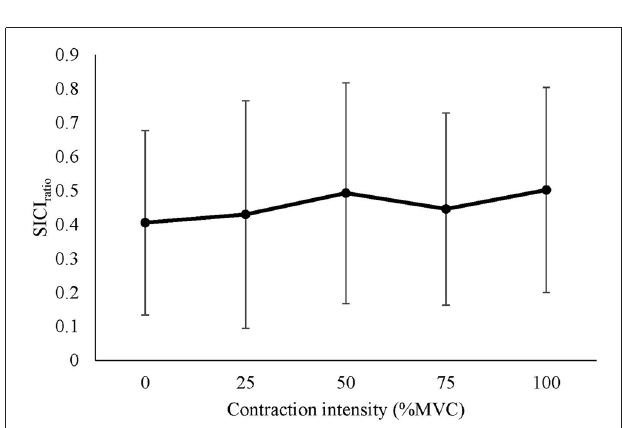
FIGURE 5 | Mean ± SD SICI ratio recorded from the active right RF during isometric contraction of the left quadriceps.